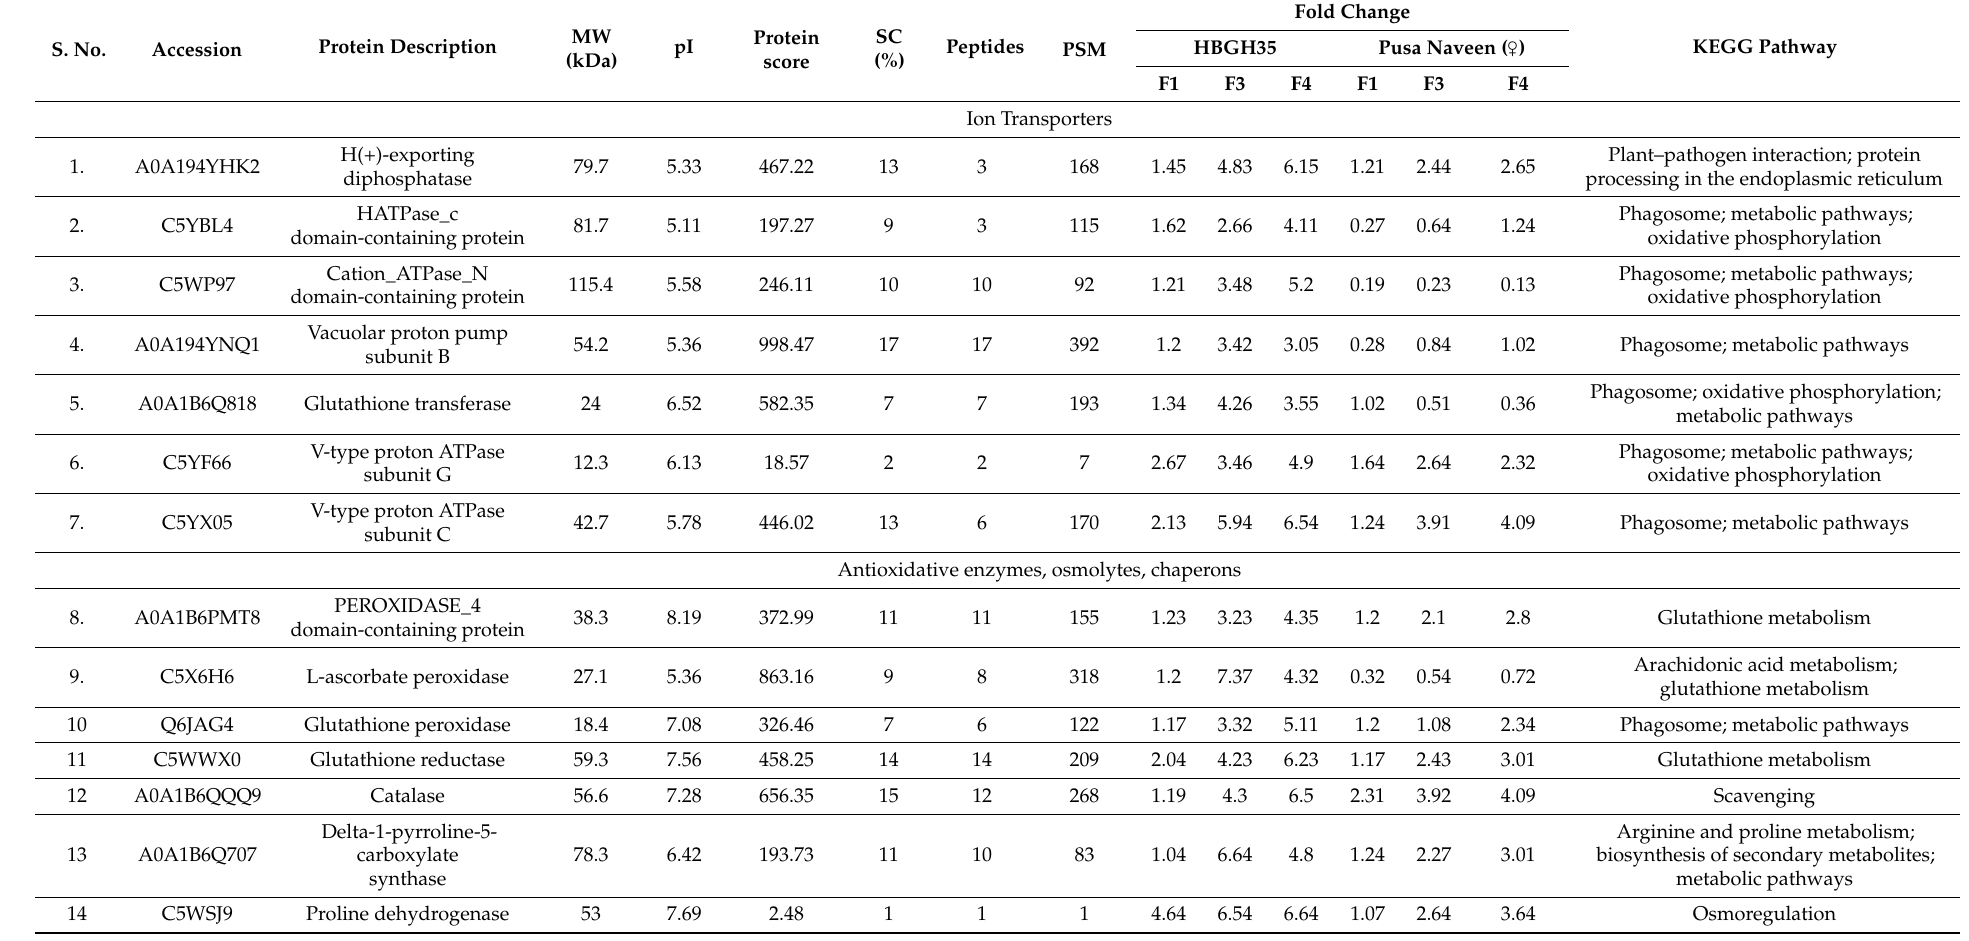
) at various crossing ♀